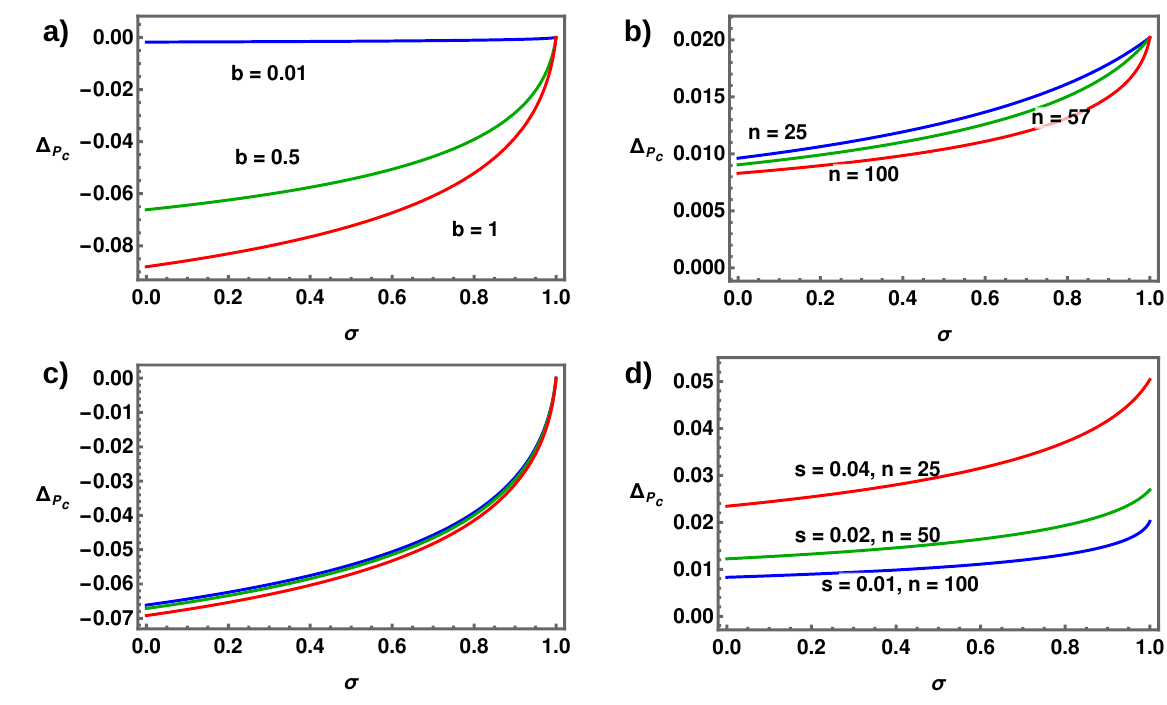
¯∆ P c , see Eq. B5) as a function of − ¯∆ P c for the same